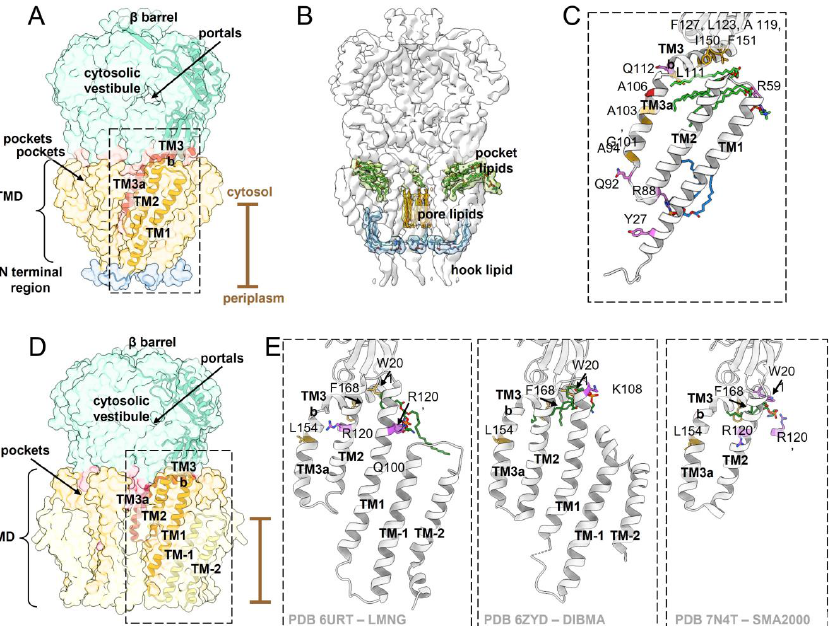
Figure 2. Architecture and lipid coordination of MscS and YnaI. ( A ) The surface of MscS in its closed conformation (PDB 6RLD [19]) is shown in transparent colors, and one subunit is additionally depicted as ribbon. The cytosolic vestibule is colored in green, the kinked pore helix TM3 in red, the sensor paddle helices TM1 and TM2 in orange, and the N terminal region in blue. The helices TM1, TM2, and TM3a comprise the transmembrane domain (TMD). The position of the membrane is indicated by the brown bar. ( B ) The EM density for MscS (EMDB 4919 [19]) is shown in white, and the densities of bound lipid molecules are shown in transparent colors with the stick model. The pocket lipids are depicted in green, the pore lipids in orange, and the hook lipids in blue. For better visibility, a gaussian filter was applied to the map. ( C ) The section highlighted in the dashed box in ( A ) is shown and specific residues are shown as sticks. The model is shown as white ribbon; pocket lipid molecules are shown in green, and the hook lipid in blue. Pocket residues in contact with lipids are colored yellow, residues that are probably involved in lipid binding are purple, and residue A106 is red. ( D ) For the larger paralog YnaI (PDB 6URT [24]) the same depiction and color code was used as for the MscS structures. YnaI has a second set of sensor paddles (yellow), that is shifted against the inner helix bundle (TM-1 (“minus 1”) and TM-2 (“minus 2”); ( E ) The section in the dashed box indicated in ( D ) is shown for three independently obtained YnaI models (left: PDB 6URT [24], middle: PDB 6ZYD [23], right: 7N4T [25]) and residues are colored as described for MscS in ( C ). Only the residues interacting with the lipid as described in the corresponding studies are depicted in purple. Pocket lipid molecules (green) for YnaI were observed in different positions and orientations in